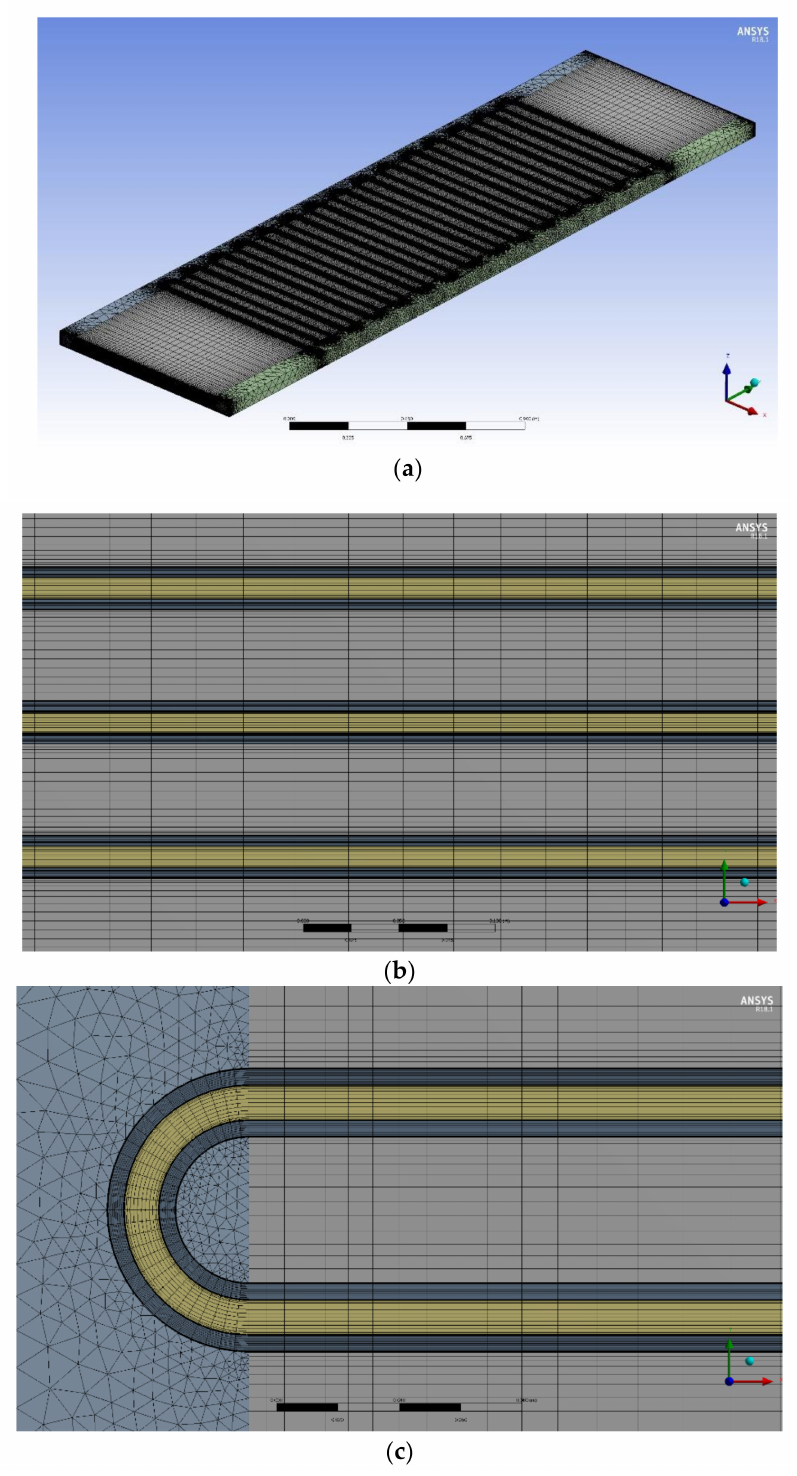
Figure 5. Mesh distributions on the scaled SCO 2 heat exchanger: ( a ) overall mesh distributions, ( b ) mesh distributions around the straight tube position, ( c ) mesh formation near the tube bending area. For the continuity